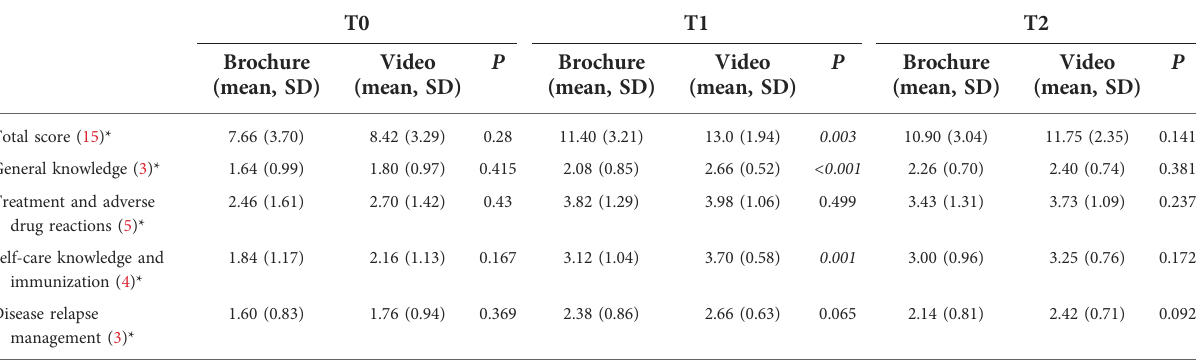
TABLE 2 Mean knowledge scores in different domains before intervention (T0), immediately after intervention (T1), and at 4 weeks post-intervention (T2) between the brochure and video groups.